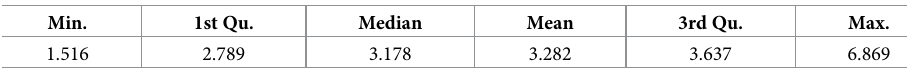
Table 8. The summary measures of the second COVID-19 data set.